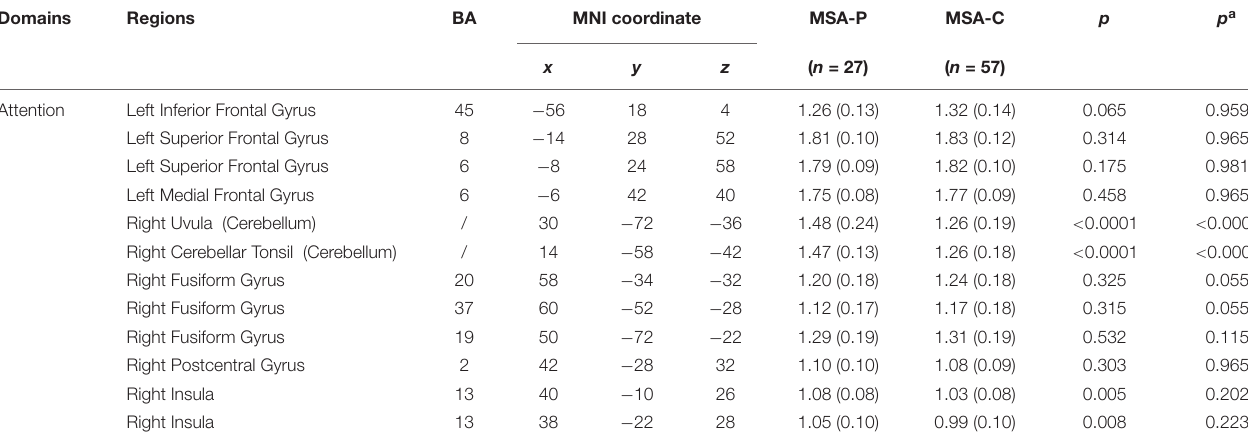
FIGURE 3 | Differences of normalized rCMRglc in representative attention-related regions between two subtypes of patients with MSA. The error bars represent SD. ∗∗∗ p < 0.0001; ∗ p < 0.01; ns p > 0.05. rCMRglc, regional cerebral metabolic rate of glucose; MSA-P, multiple system atrophy with predominant parkinsonism; MSA-C, multiple system atrophy with cerebellar ataxia. TABLE 4 | Differences of regional brain metabolism in attention-related areas between patients with MSA with predominant parkinsonism (MSA-P) and MSA with predominant cerebellar ataxia (MSA-C).